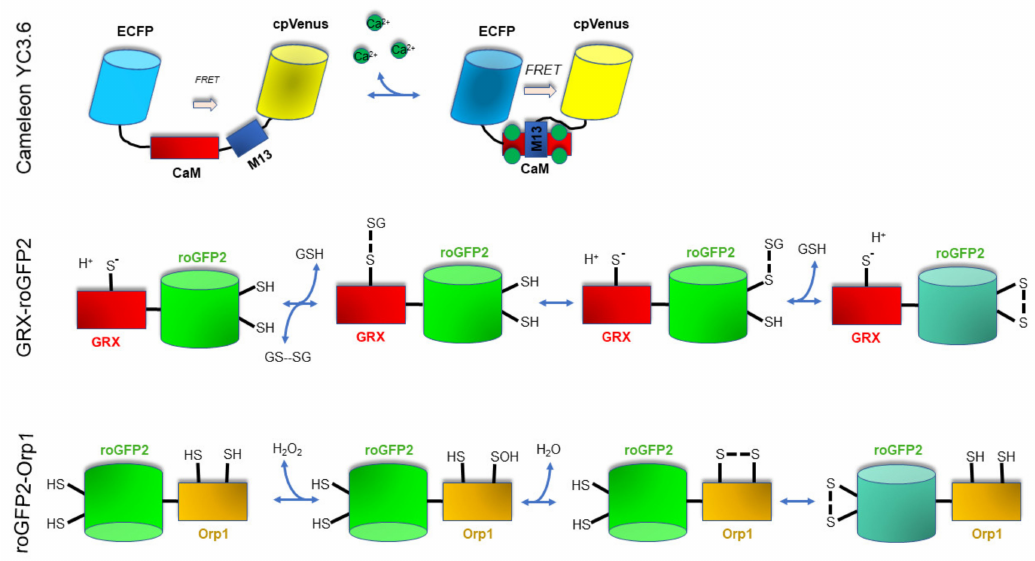
Figure 2. Schematic structure of a Ca 2+ sensor (Cameleon YC3.6, ( top )), a redox sensor (GRX-roGFP2, ( middle )), and H 2 O 2 sensor (roGFP2-Orp1, ( bottom )). Ca 2+ binding to the CaM domain rearranges the structure and brings the ECFP close to the cpVenus, thereby augmenting the efficiency of FRET between the two fluorescent protein domains. In the redox sensor, the oxidized glutathione dimers, accumulating during oxidative stress, react with a sensitive Cys residue of the GRX, forming a disulfide bond. The bond is transferred to the roGFP2 moiety (right) and eventually affects fluorescence emission. When reduced GSH prevails, the sensor is brought back to the reduced form. The ROS sensor reacts with H 2 O 2 (left), forming a sulfenic group. This undergoes dehydration, leading to disulfide bridge formation, which is transferred to the roGFP2 moiety (right), altering fluorescence emission. Dashed lines between the sulfur atoms represent disulfide